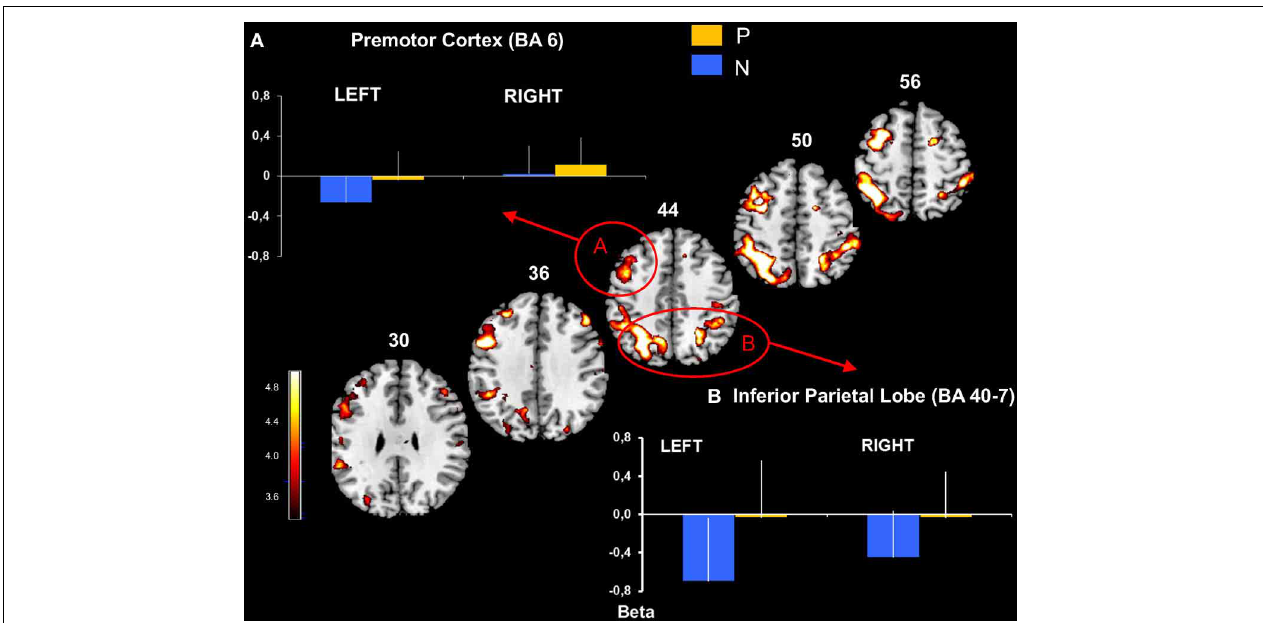
FIGURE 3 | Premotorandinferiorparietalcorticalactivationobtainedwith P > N contrast. Activated prefrontal regions shown on template axial sections including the left premotor cortex, BA 6 (A) and bilaterally the inferior parietal